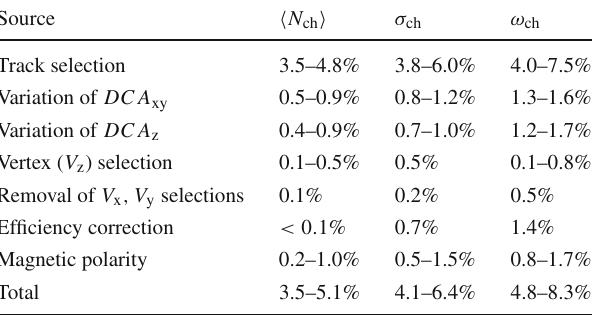
Table 1 Systematic uncertainties on the mean, standard deviation, and scaled variance of charged-particle multiplicity distributions from dif- ferent sources. The ranges of uncertainties quoted correspond to central to peripheral collisions